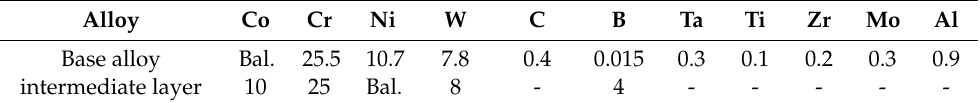
Table 1. Chemical composition of base alloy and used intermediate alloy (wt.%).